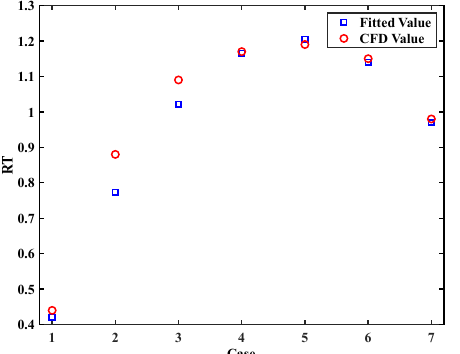
Figure 25. RT fitted cases in 120 m/s database.